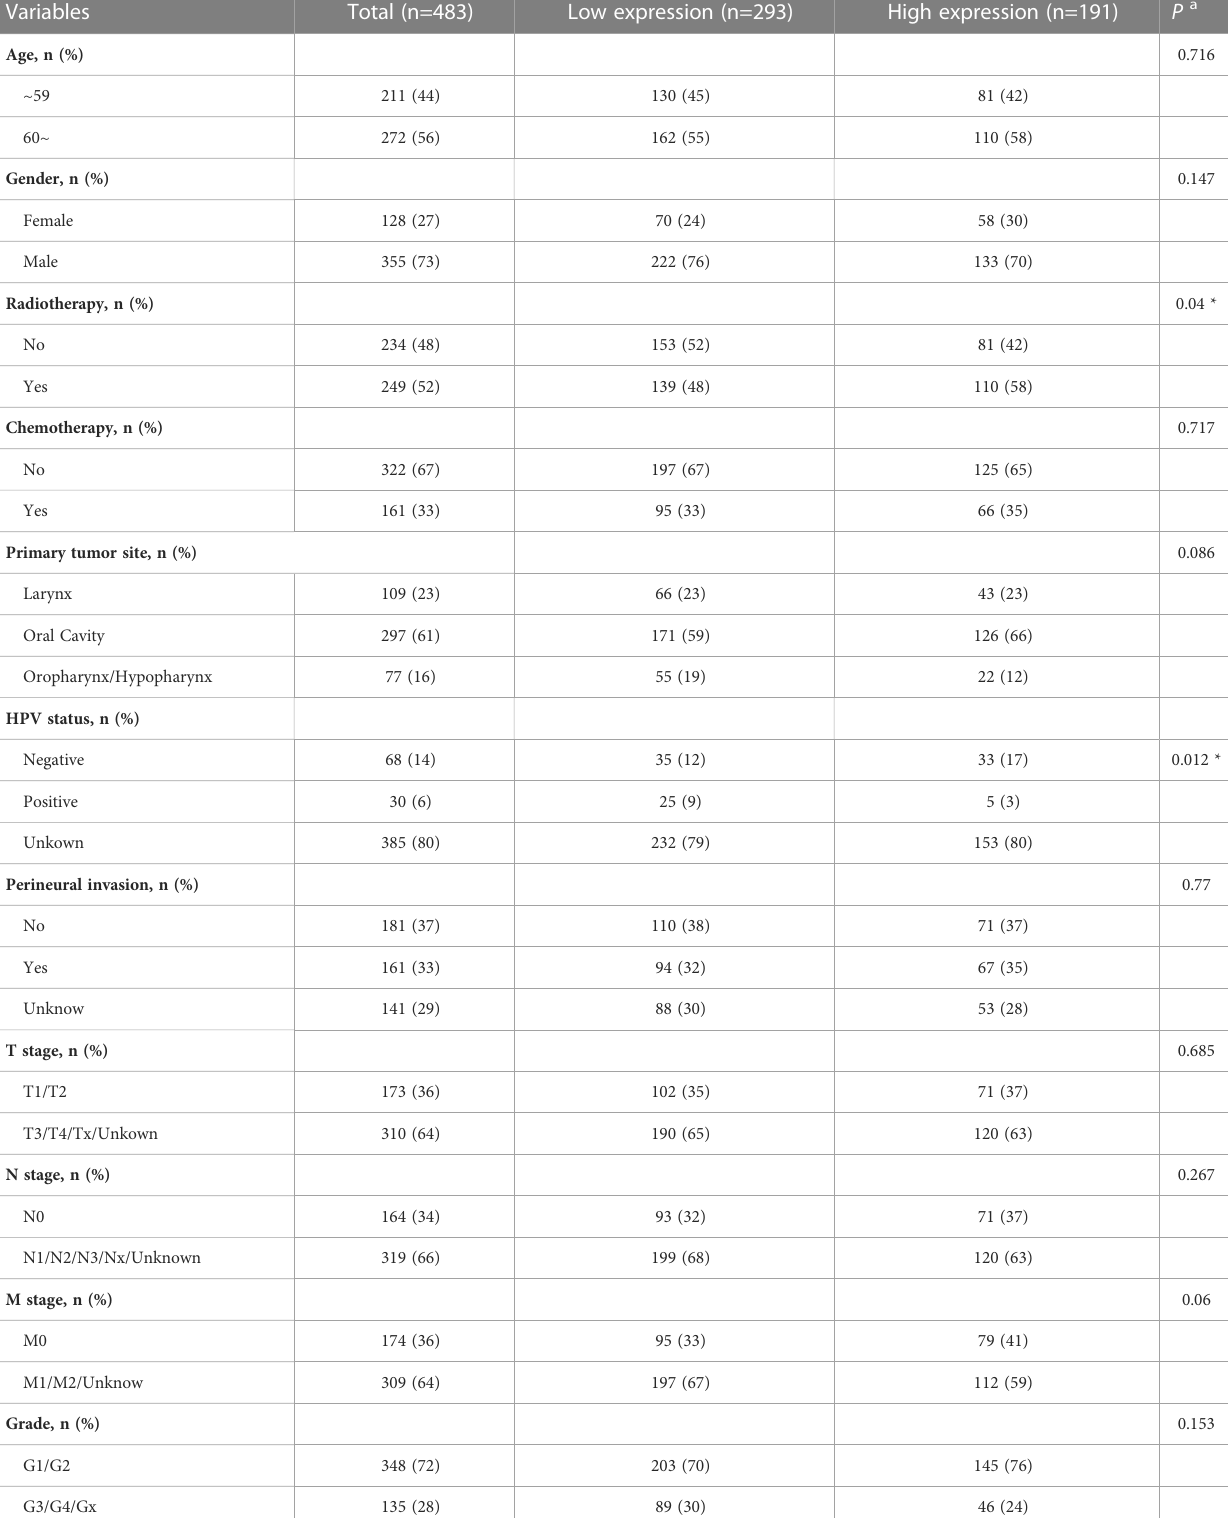
TABLE 1 Baseline characteristics of patients with HNSCC in the IL1B high- and low-expression